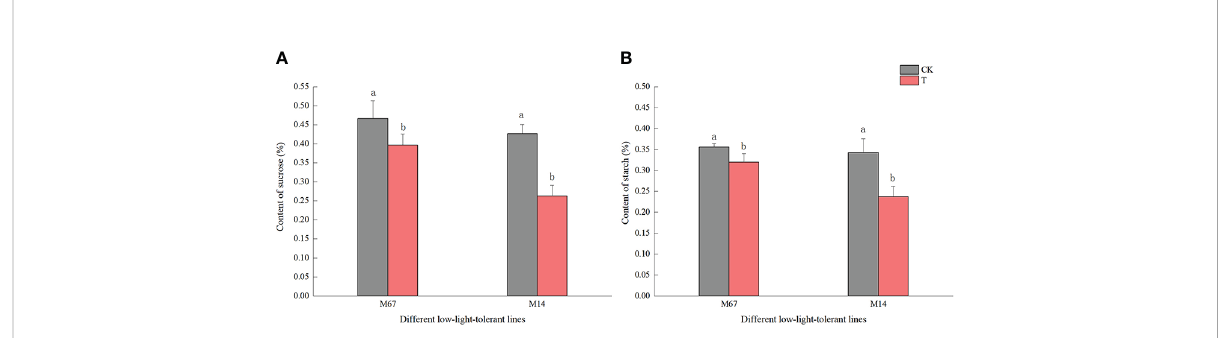
FIGURE 2 Effects on content of starch and sucrose in leaf of low-light stress in different cucumber lines. (A) starch and (B) sucrose content in leaf under control and low-light stress in different cucumber lines. Lowercase letters a and b after the value represent statistically signi fi cant differences (p < 0.05) within a variety under different low-light treatments as determined by the least signi fi cant difference